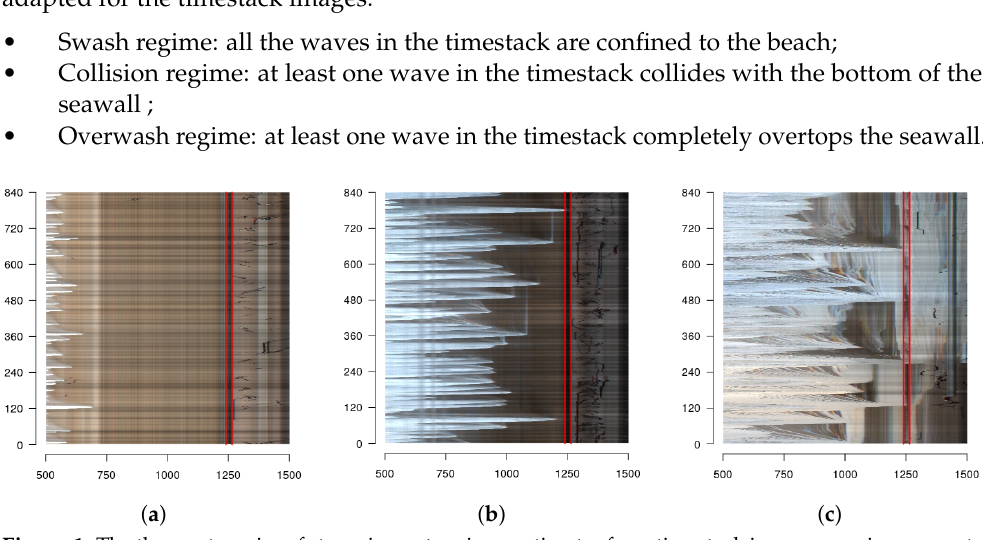
Figure 1. The three categories of storm impact regimes estimates from timestack images. y -axis represents the time in seconds, x -axis represent the pixel index (cropped images), and red lines represent the sea wall bottom and top positions. ( a ) Swash regime. ( b ) Collision regime. ( c ) Overwash